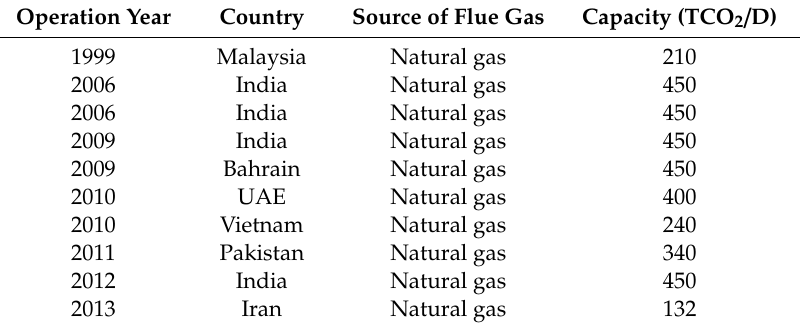
Table 1. Commercialized carbon capture and utilization (CCU) plant for urea production. Operation Year Country Source of Flue